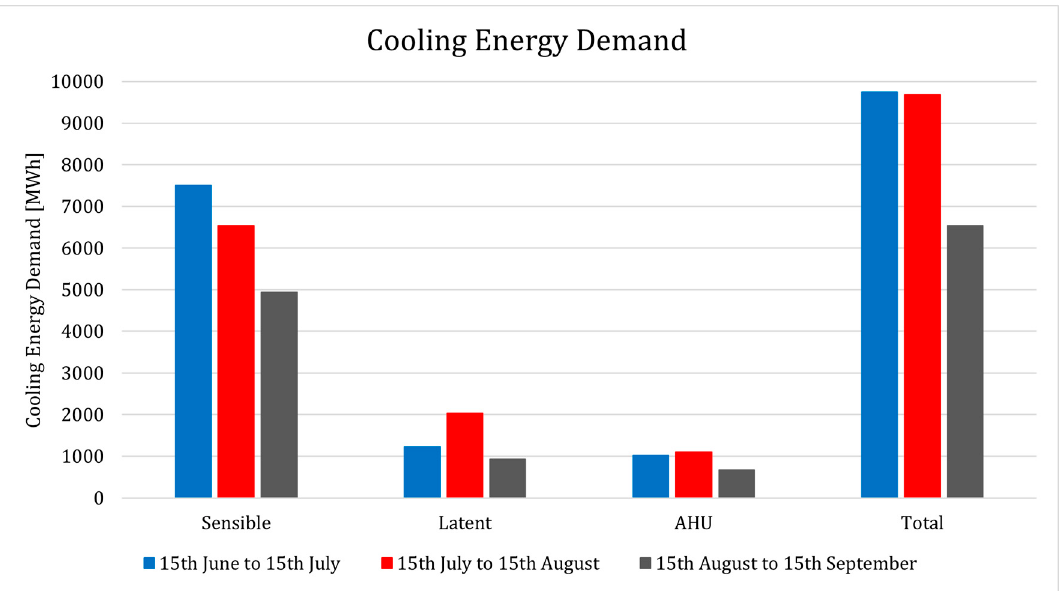
Figure 8. District cooling energy demand without considering the interaction between buildings.